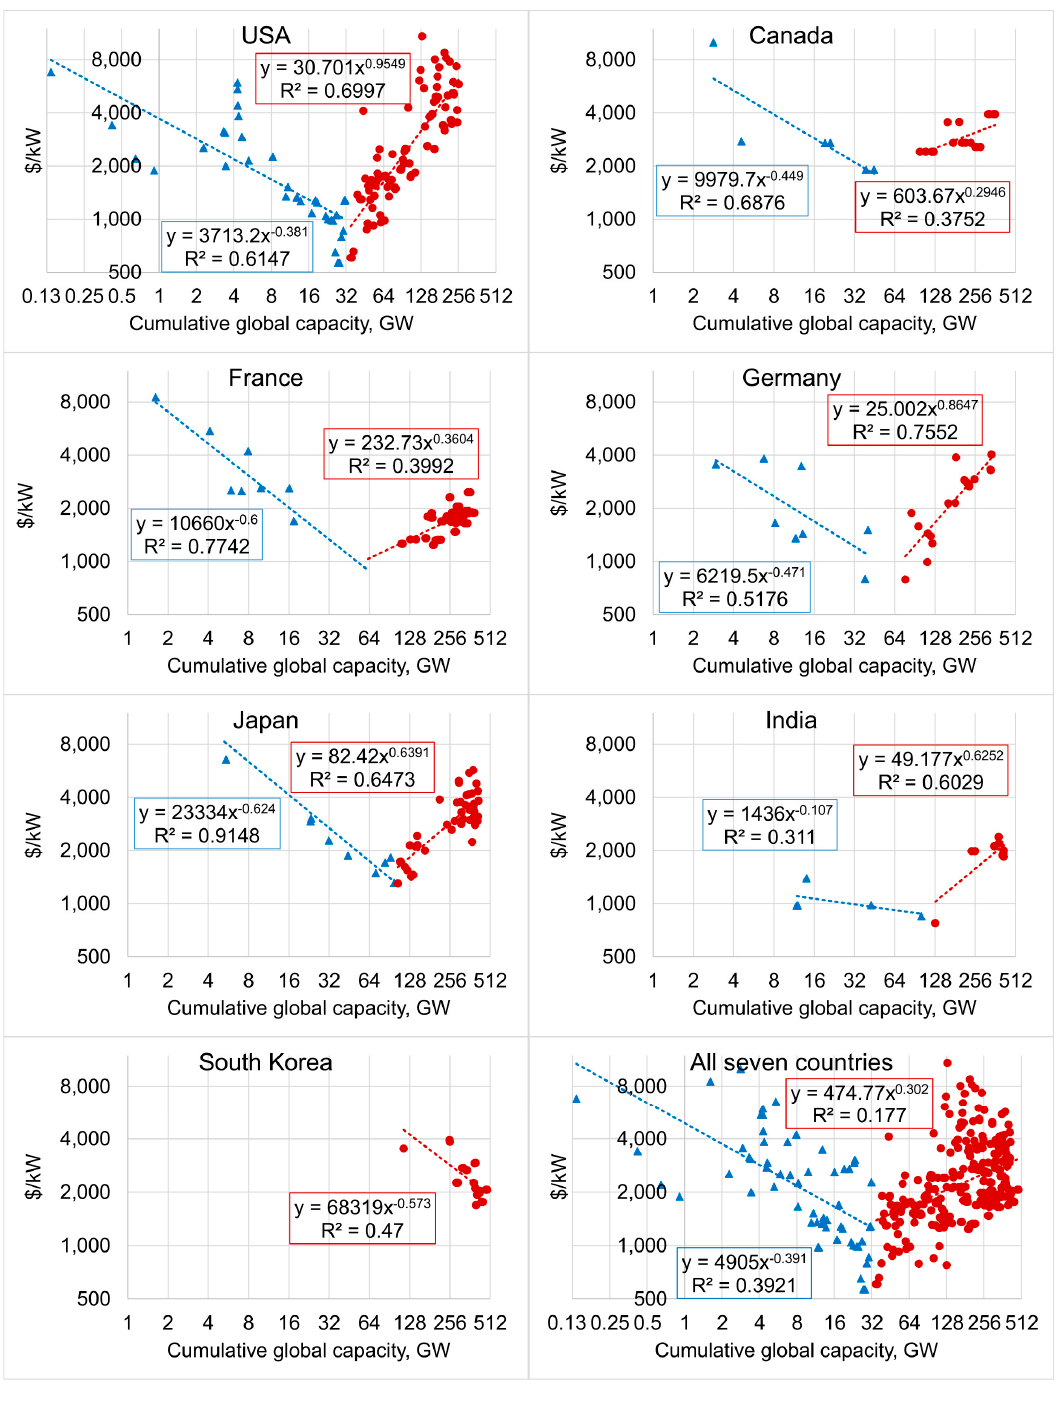
Figure 2. OCC (2010 US $/kW) plotted against cumulative global capacity (GW) of nuclear power reactors, based on construction start dates; regression lines fitted to points before and after trend reversals.